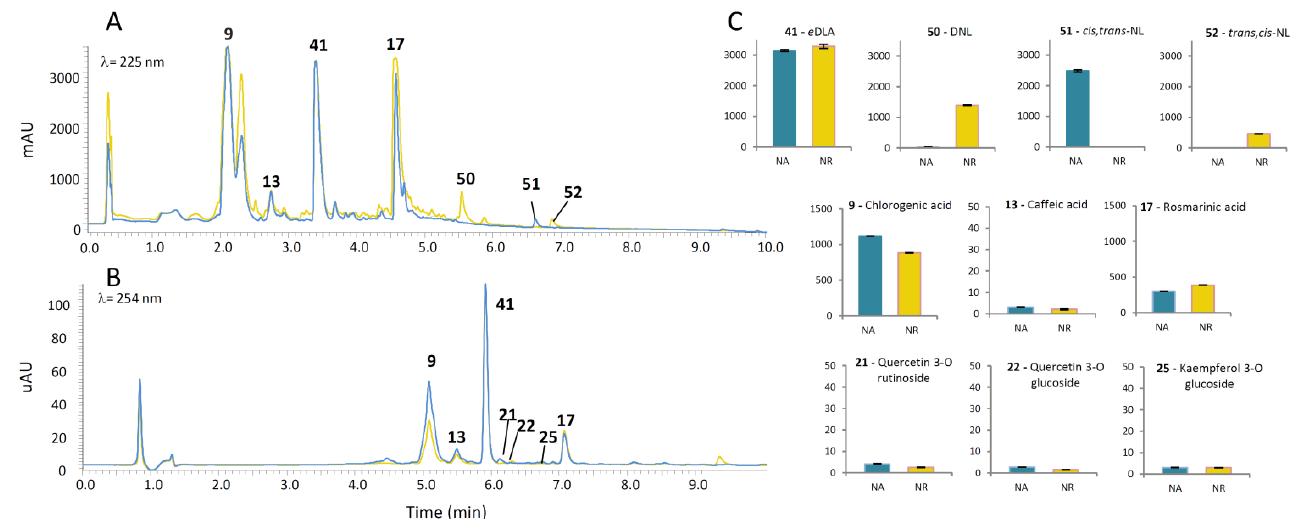
Figure 3. UHPLC/DAD chromatograms of N. rtanjensis (yellow line) and N. argolica subsp. argolica methanol extracts (blue line) representing: ( A ) major iridoid compounds: cis,trans -NL (51) and trans,cis -NL (52), both displaying pseudomolecular ion [M+H] + at 167 m/z , visible as peaks eluting at Rt = 6.62 min and 6.87 min, respectively; DNL (50), with pseudomolecular ion [M+H] + at 165 m/z , eluting at Rt = 5.54 min; 1,5,9-eDLA (41) with [M − H] − at 359 m/z , visible as a peak at Rt = 5.54 min; ( B ) major phenolic compounds: 5- O -caffeoylquinic acid (9) displaying [M − H] − at 353 m/z and eluting at Rt = 5.18 min; ca ff eic acid (13) with [M − H] − at 179 m/z and eluting at Rt = 5.58 min; rosmarinic acid (17) with [M − H] − at 359 m/z , visible as a peak eluting at Rt = 7.17 min; quercetin rutinoside (21) with [M − H] − at 609 m/z, eluting at Rt = 6.19 min; quercetin 3- O -glucoside (22) displaying [M − H] − at 463 m/z, eluting at Rt = 6.44 min; kaempferol 3-O-glucoside [M − H] − at 447 m/z, eluting at Rt = 6.76 min. Quantitative data ( C ) are presented as µg 100 mg –1 FW.